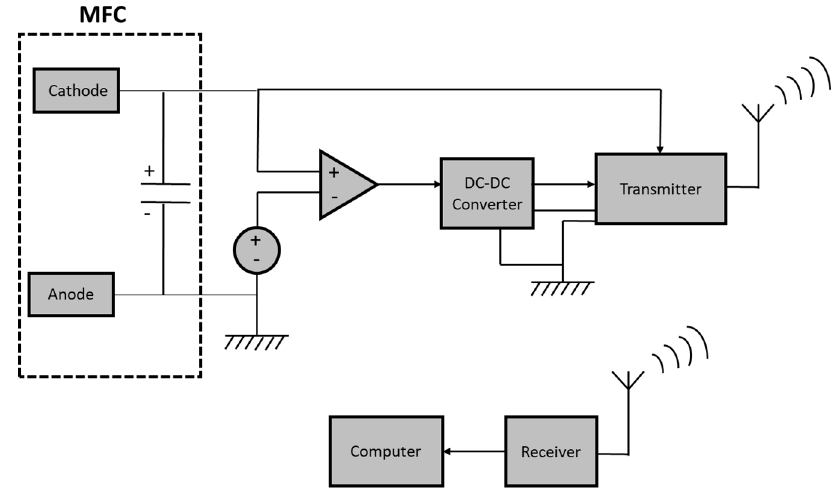
Figure 4. Schematic diagram of a remote sensor powered by an MFC with a DC/DC converter.